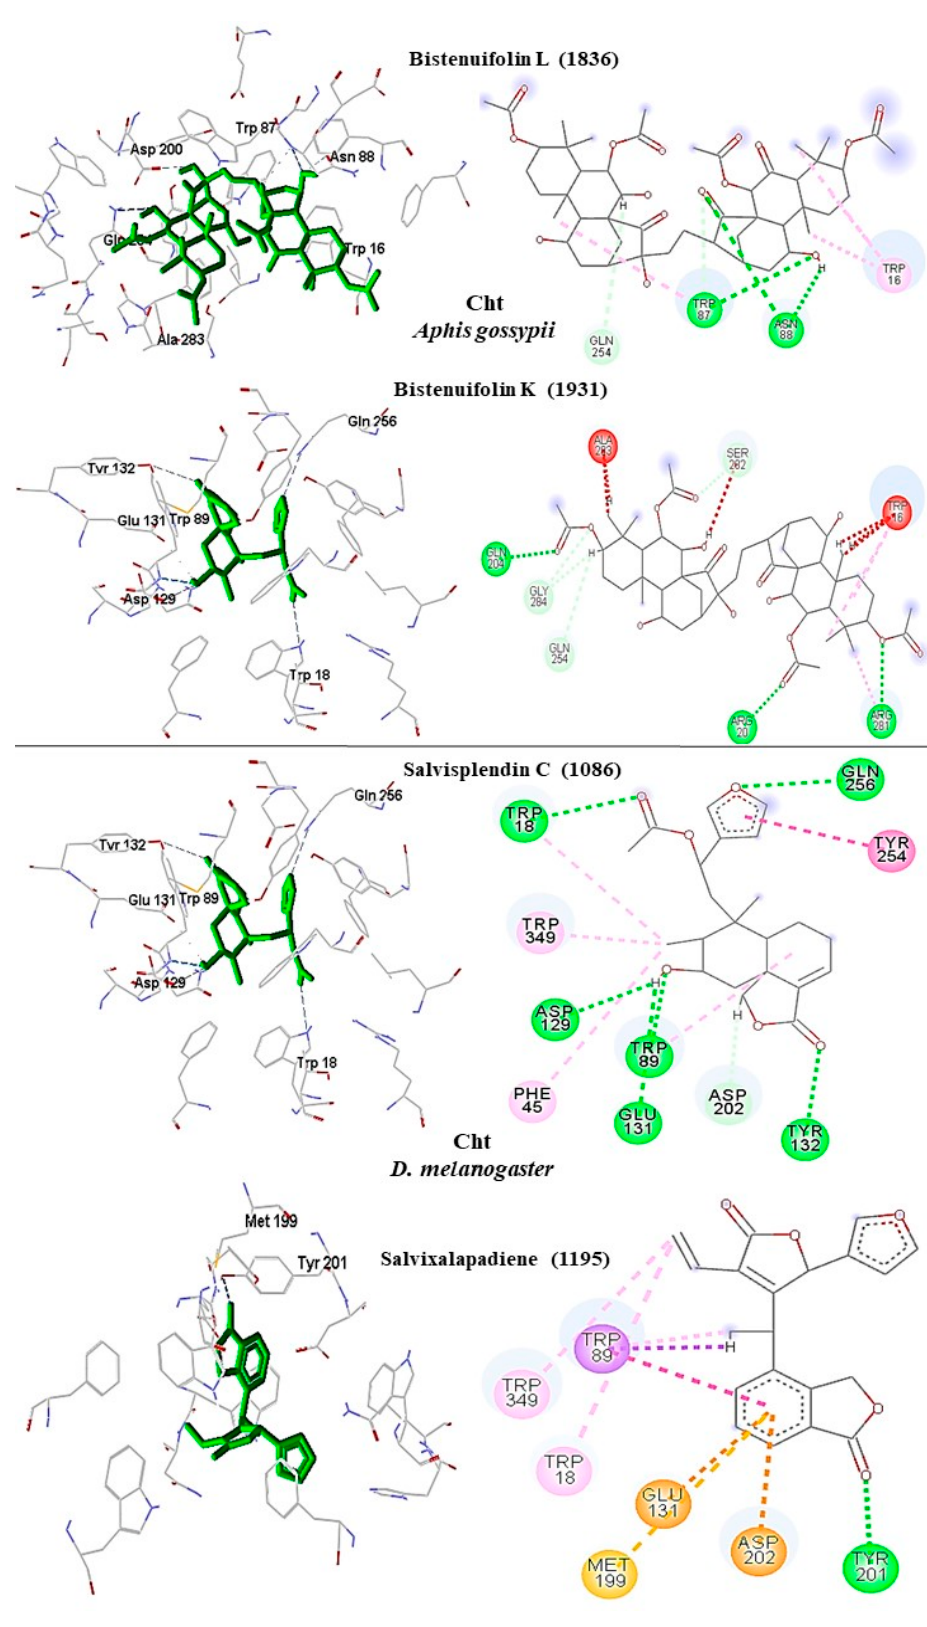
Figure 9. Interactions (3D and 2D) between 1836 and 1931 and A. gossypii -Cht; and between 1086 and 1195 and D. melanogaster -Cht. Hydrogen bonds are highlighted in green, hydrophobic interactions are highlighted in pink, and steric interactions are highlighted in red.